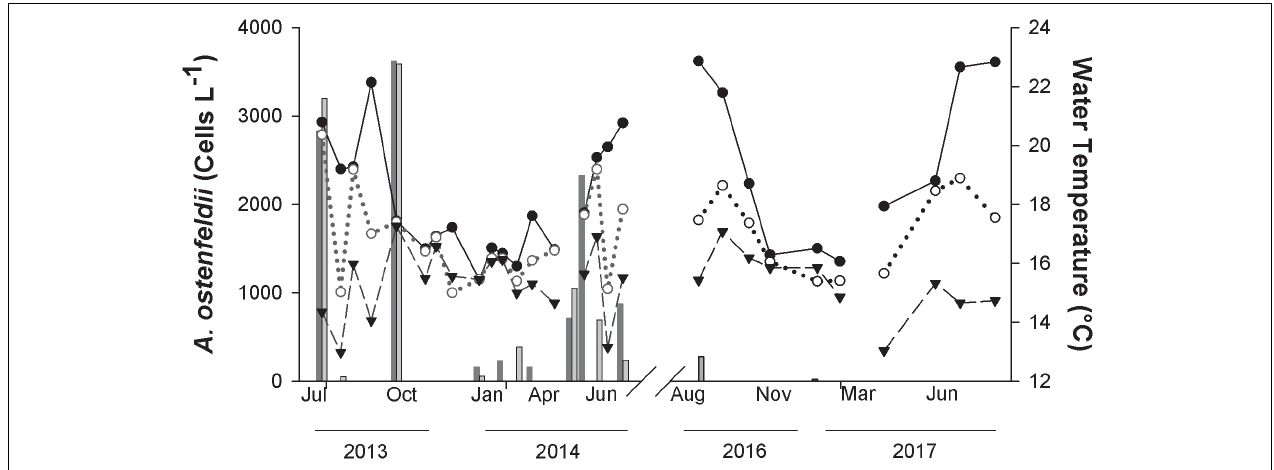
FIGURE 8 | Temperature at surface (closed circles), 5 m (open circles) and 10 m depth (closed triangles) at Station 13 (Rincón de Ballenas) in Todos Santos Bay. The cell abundance of A. ostenfeldii in samples at surface (dark gray bar) and 10 m or thermocline (light gray bar) is also presented.